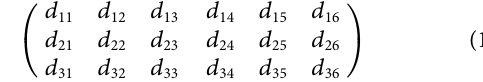
Frontiers in Mechanical Engineering |